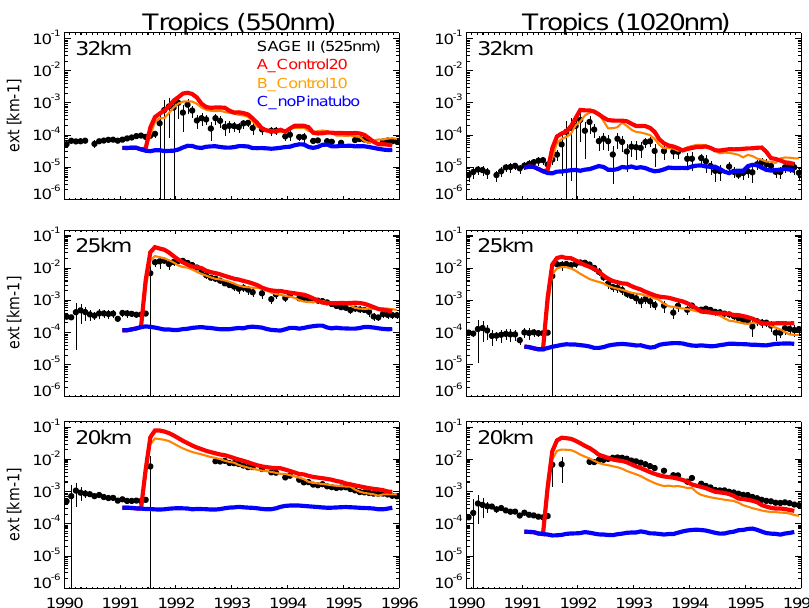
Figure 5. Comparison between modelled and SAGE II (V7.0) retrieved extinction at 525nm (left) and 1020nm (right) in the tropics (20 ◦ S– 20 ◦ N) for 20km (bottom), 25km (middle) and 32km (top). Extinctions from runs A_Control20, B_Control10 and C_noPinatubo are shown with red, orange and blue lines, respectively. The vertical black lines show the range of plus or minus one standard deviation over the individual measurements used in the calculation of the monthly mean.